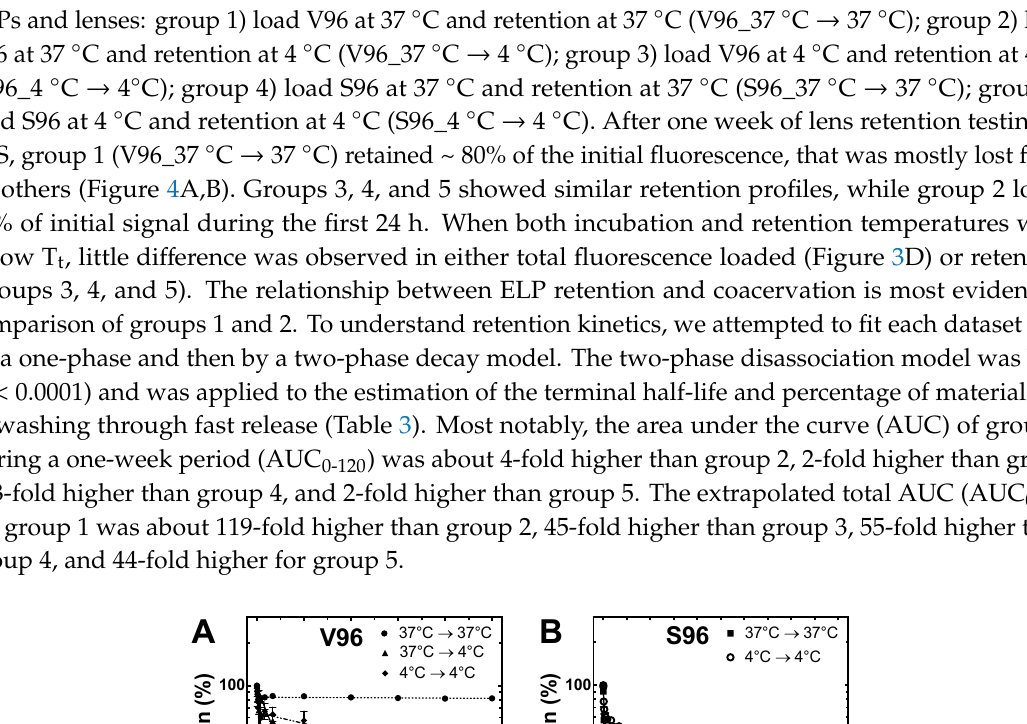
Table 3. Release kinetics of ELPs from Proclear Compatibles TM contact lenses